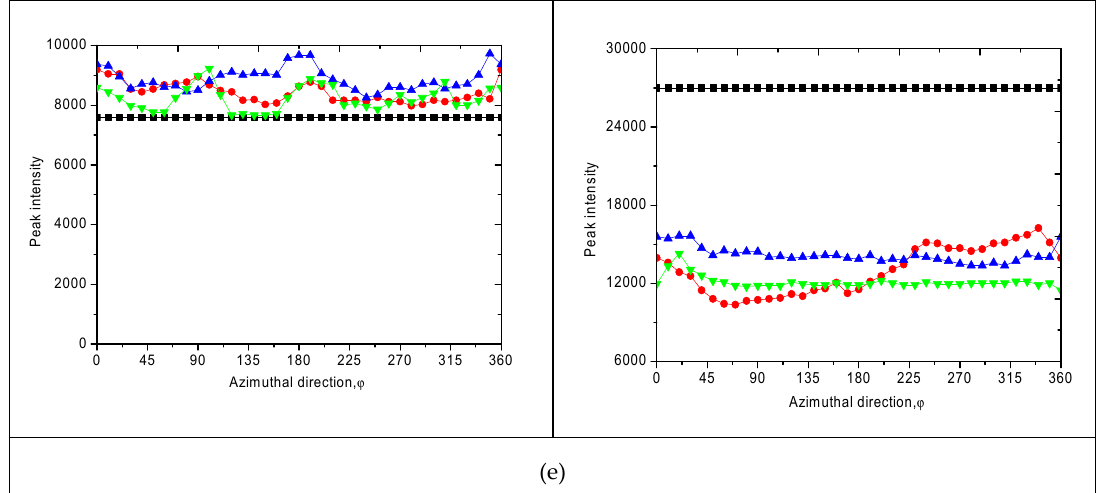
Figure 3. Azimuthal variations in the intensity of diffraction reflections (black line – initial sample; red line – irradiated by Kr 13+ ions; blue line – irradiated by Kr 14+ ions; green line – irradiated by Kr 15+ ions): ( a ) 5.0 × 10 10 ion/cm 2 ): ( b ) 7.5 × 10 10 ion/cm 2 ; ( c ) 1.0 × 10 11 ion/cm 2 ; ( d ) 2.5 × 10 11 ion/cm 2 ; ( e ) 5.0 × 10 11 ion/cm 2.